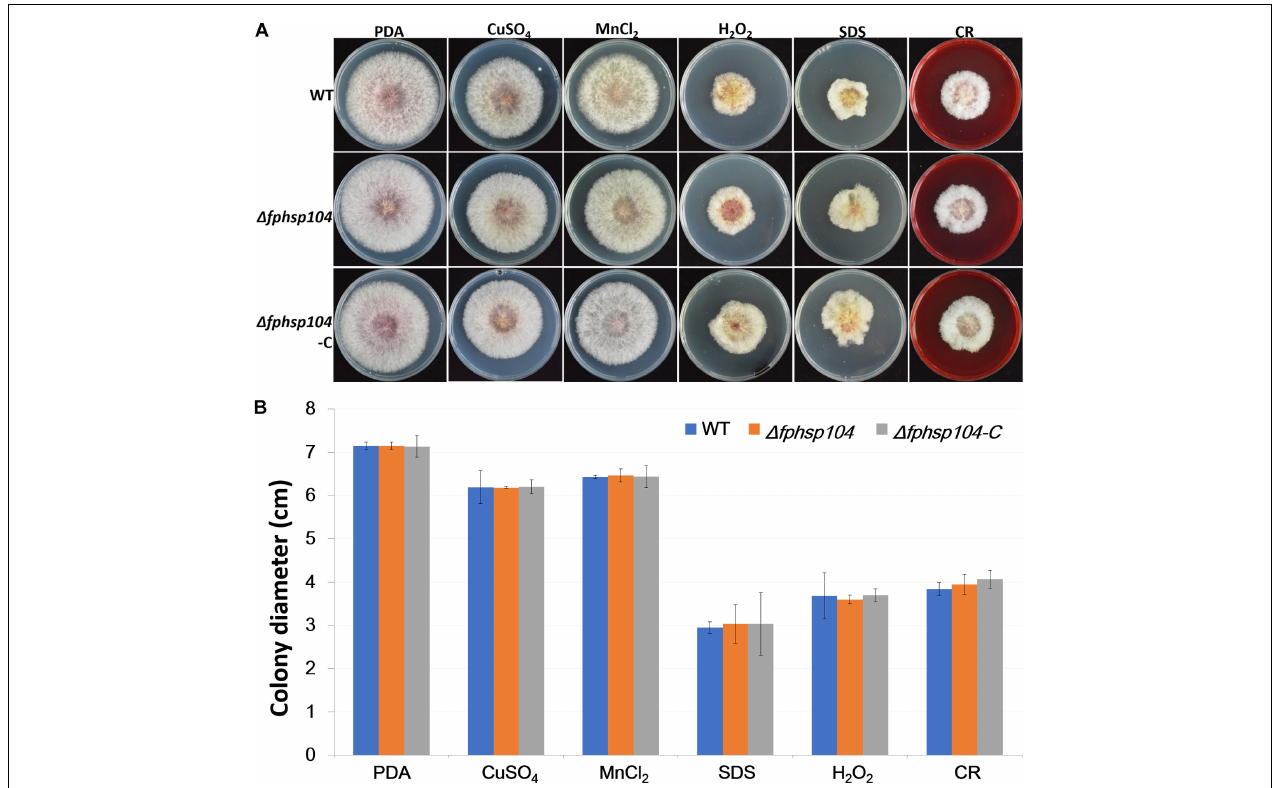
FIGURE 4 | Effects of osmotic stress, oxidative stress, and cell wall stress. (A) Phenotypes of wild-type (WT), (cid:49) fphsp104 , and (cid:49) fphsp104 -C strains inoculated on potato dextrose agar (PDA) medium with osmotic stress factors (CuSO 4 and MnCl 2 ), oxidative stress factor (hydrogen peroxide), and cell wall stress factors (SDS and congo red [CR]). (B) Growth rates of the strains under osmotic, oxidative, and cell wall stresses. Results are presented as the mean ± standard deviation of at least three independent experiments. Data were analyzed using t -tests in Excel.